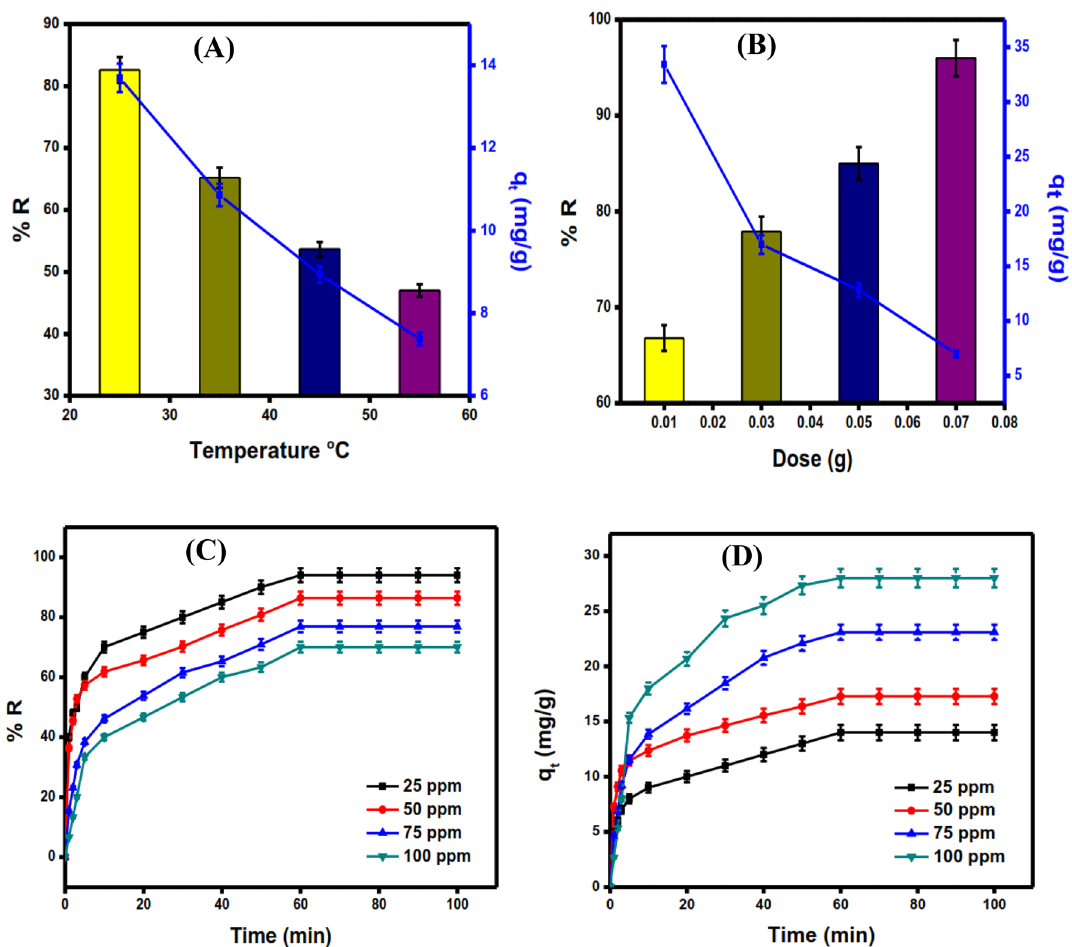
Figure 7. Temperature effect on removal efficiency and adsorption capacity of DC onto rGO/nZVI composite ( A ) [C o = 50 mg L −1 , pH = 7, and dose = 0.05 g], Adsorbent dose effect on the removal efficiency and removal efficiency of DC onto rGO/nZVI composite ( B ) [C o = 50 mg L −1 , pH = 7, and T = 25 °C], initial concentration effect on the adsorption capacity and removal efficiency of DC onto rGO/nZVI ( C , D ) [C o = 25–100 mg L −1 , pH = 7, T = 25 °C, and dose = 0.05